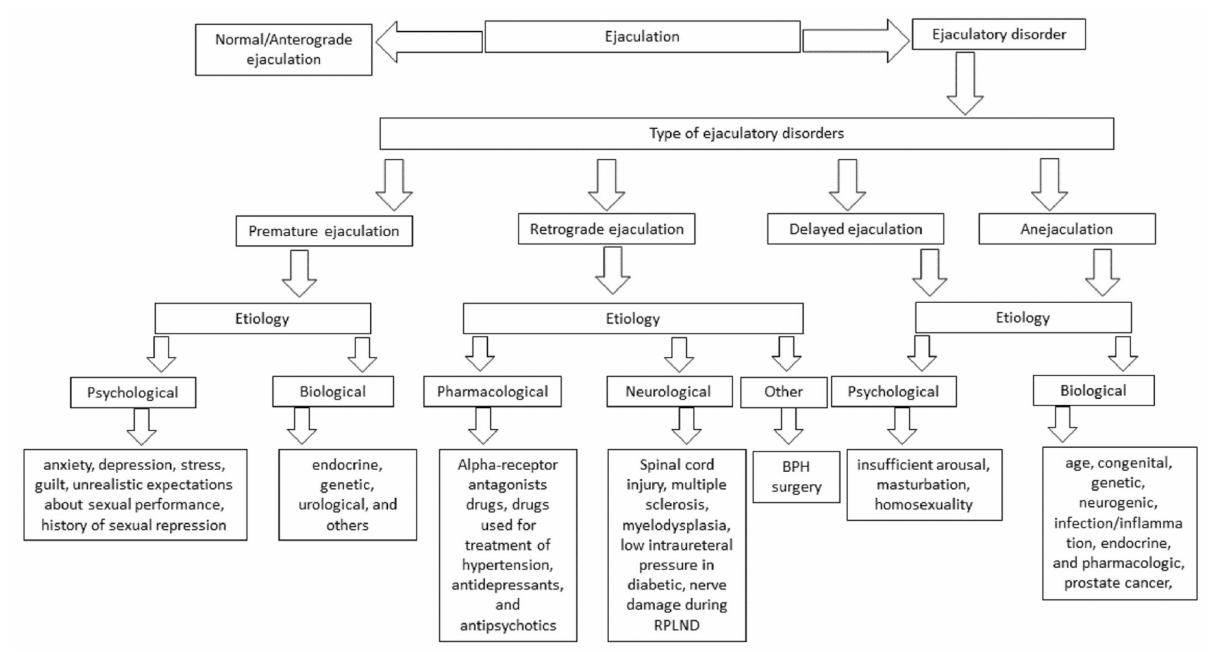
Figure 3. Table showing the normal and abnormal types of ejaculation. Their etiologies are described in